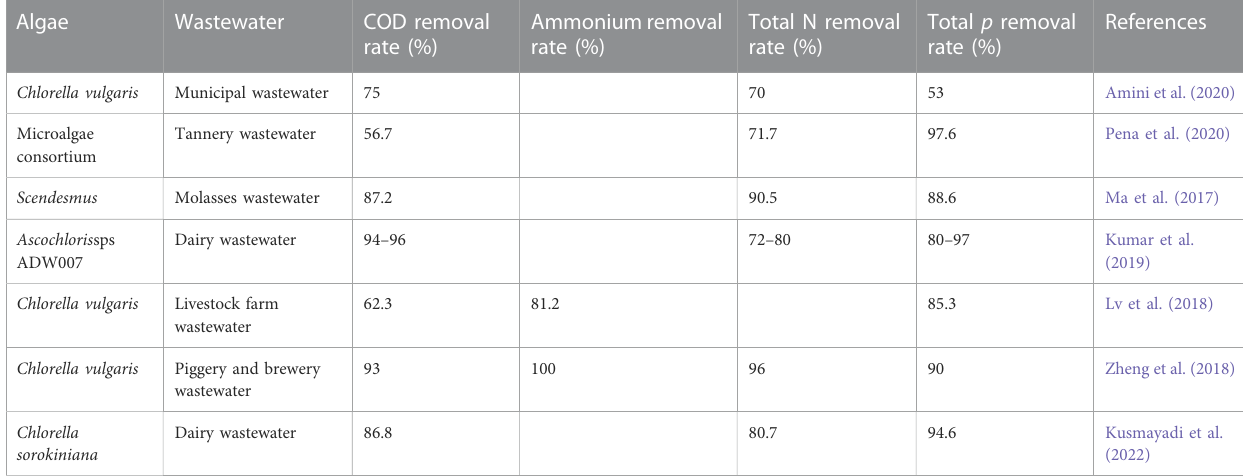
TABLE 3 Microalgae cultivation in wastewater treatment with nutrients